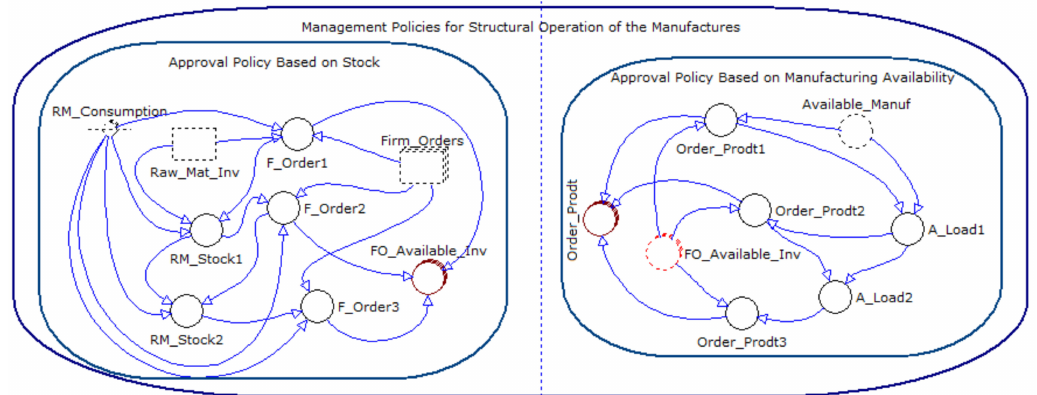
Figure 6. Structural operating policies of the model. Source: own elaboration. Evolution Software Evolution